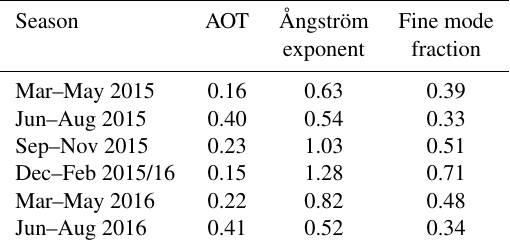
Table 2. Seasonal means of the sun photometer measurements (AERONET Level 1.5, cloud-screened). AOT at 500nm wave- length, Ångström exponent from the 440–870nm spectral range, and the fine mode fraction from 500nm